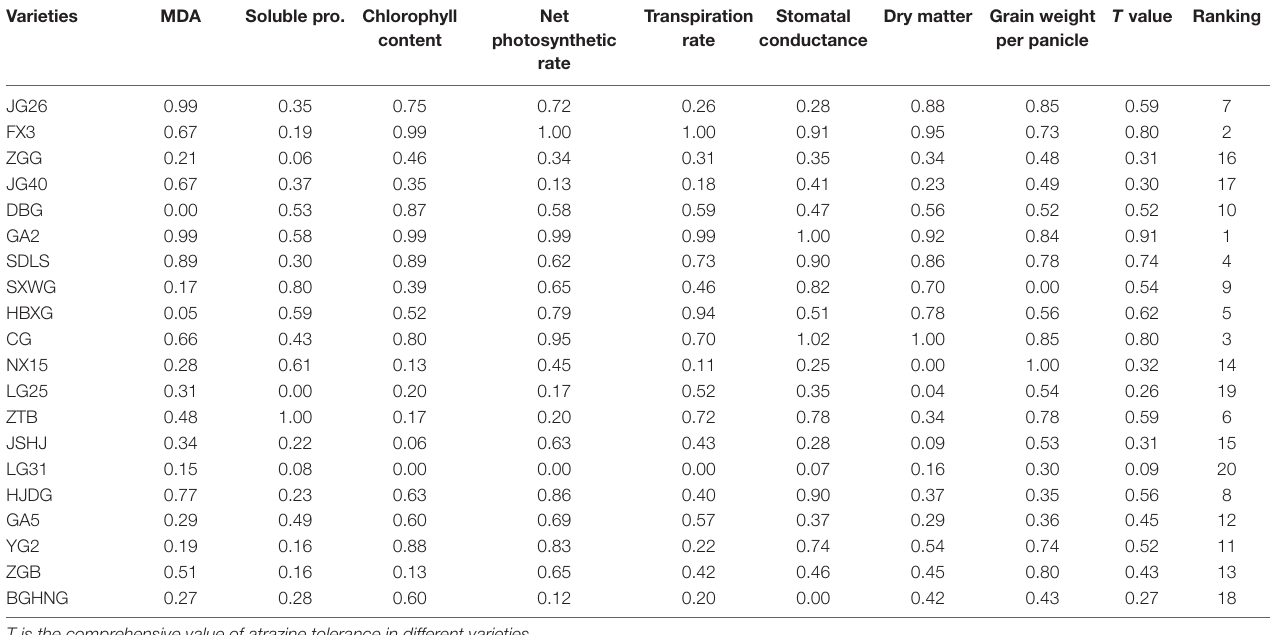
TABLE 4 | Comprehensive evaluation of foxtail millet under atrazine stress. Varieties